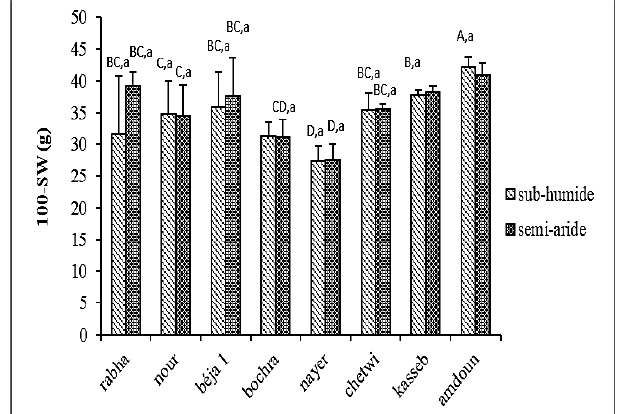
Figure 6: Mean values of 100 seeds weight as a function of the interaction’s cultivar × bioclimatic